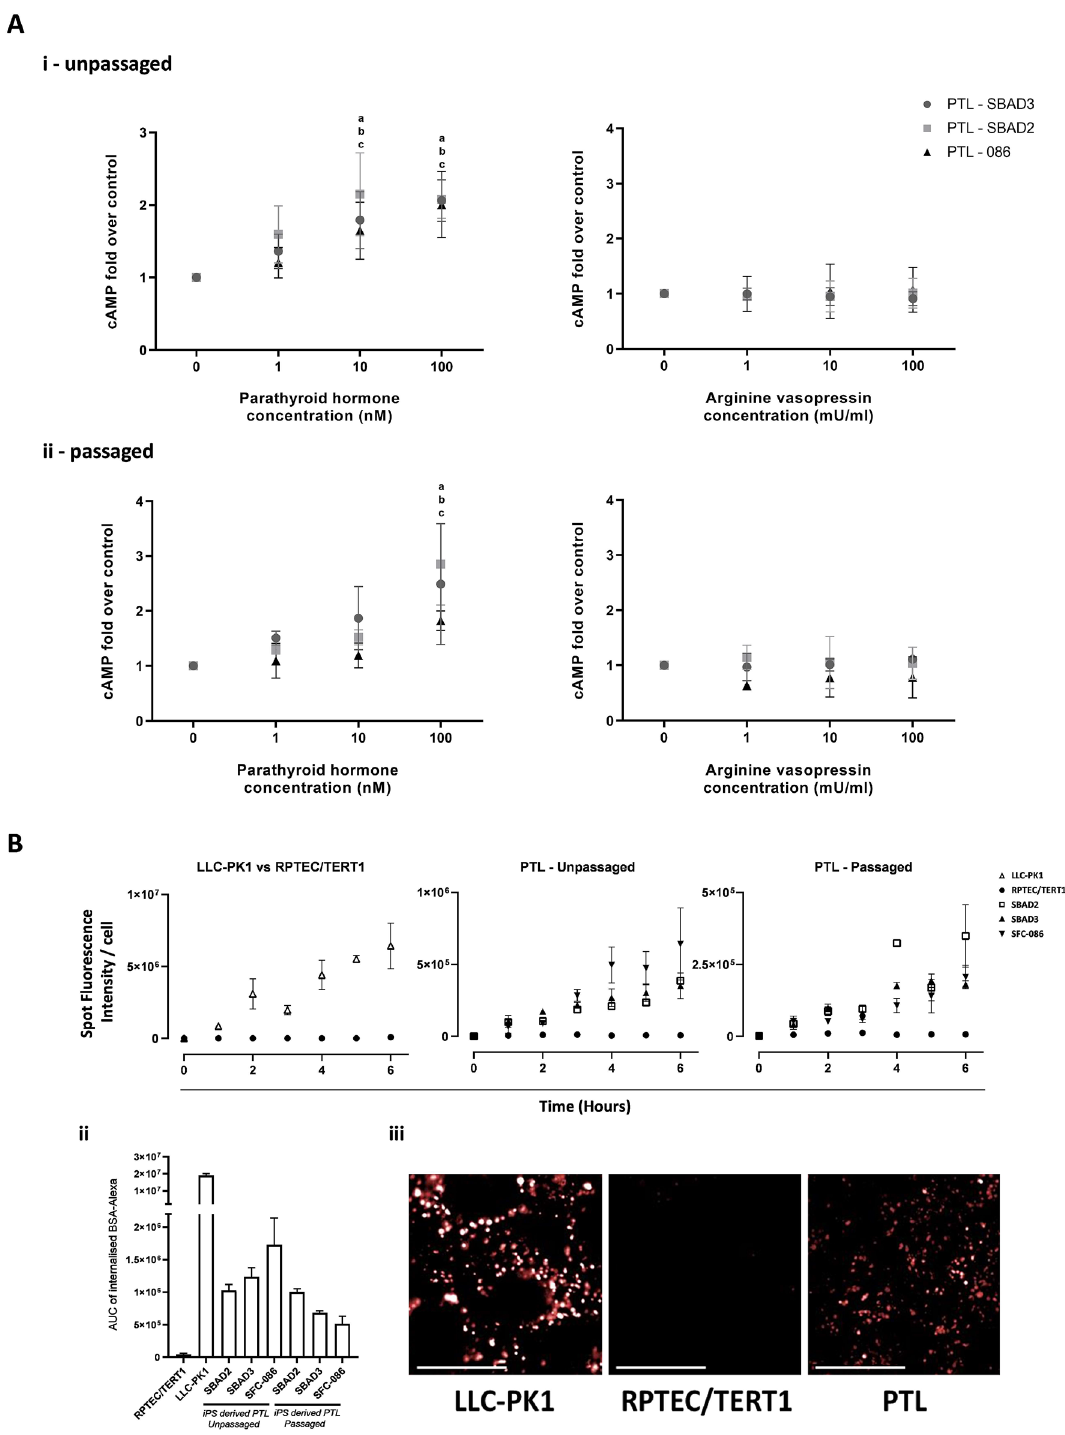
Figure 6. Functional characterisation of PTL. ( A ) Cellular cAMP response to parathyroid hormone (PTH) and arginine vasopressin (AVP). Three different iPSC lines (SBAD2, SBAD3 and 086) were differentiated on ECM until day 16 or passaged on day 16 and cultured further for 11 days. Cells were treated with different concentrations of AVP and PTH for 20 min. cAMP levels were quantified with a competitive EIA and values were normalised to IBMX controls. Data points represent the mean of at least 3 independent experiments plus and minus the standard deviation. Statistical analysis was conducted via a one-way ANOVA. a, b and c represent statistical relevance compared to control (P < 0.05), for SBAD2, SBAD3 and SFC-086 PTLs respectively. ( B ) Albumin uptake assay. iPSC derived PTLs cultured on Geltrex, RPTEC/TERT1 and LLC-PK1 were treated with 10 µg/ml BSA-Alexa-647. Images were captured using Operetta high content imager (63X water objective). The endocytosis of labelled BSA was observed as district fluorescent spots which was quantified over time (Bi) and represented as Area Under the Curve (AUC) in B-ii. Representative images are given in B-iii. Scale bar represents 20